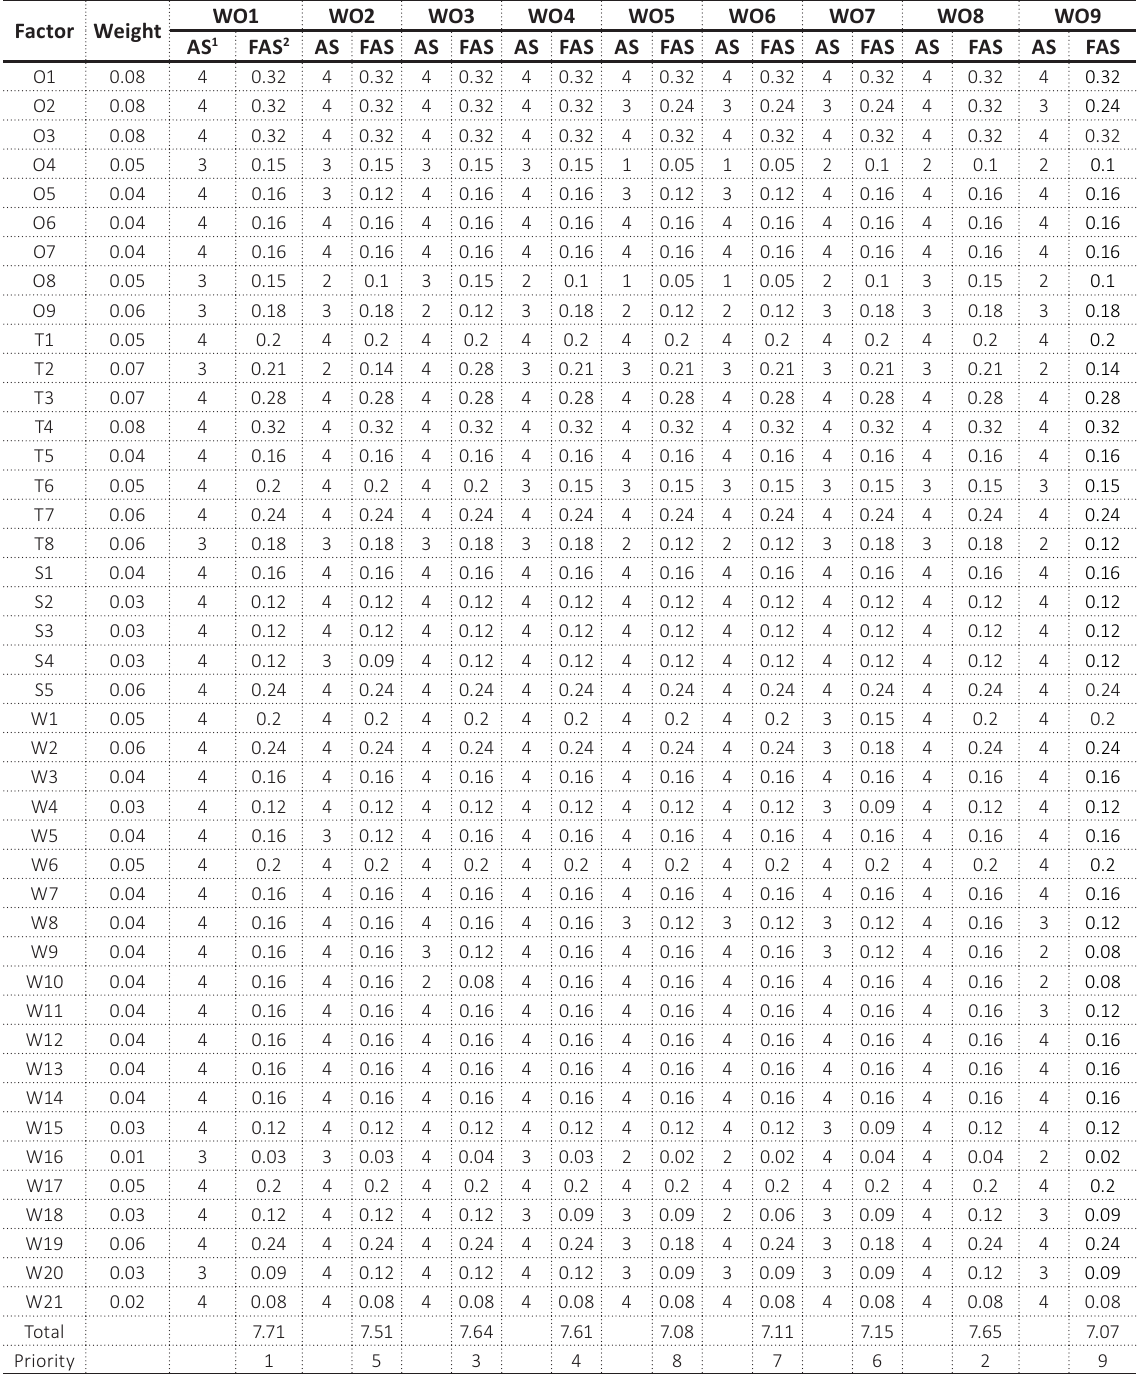
Table A1. QSP matrix of technology transfer to the agricultural sector of Kazakhstan Factor